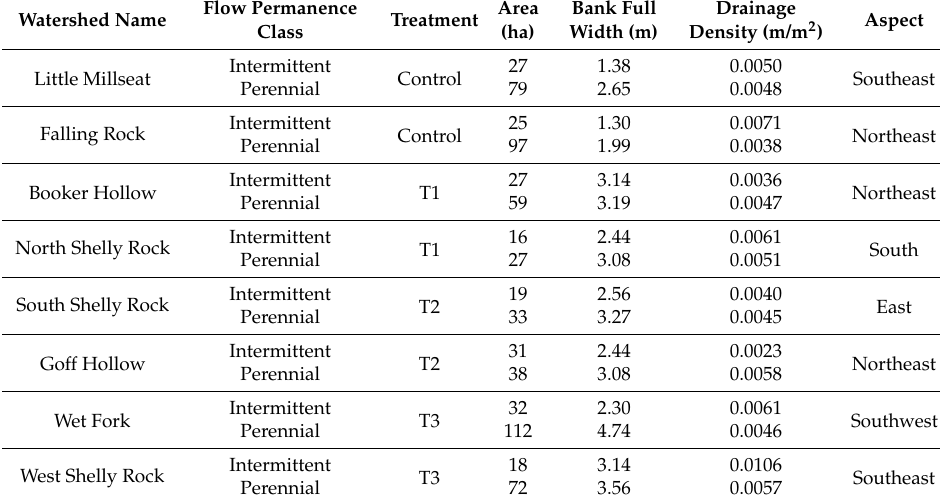
Table 1. Characteristics of the intermittent and perennial channels within each treatment watershed at Robinson Forest, Kentucky (USA). Adapted from Witt 2012